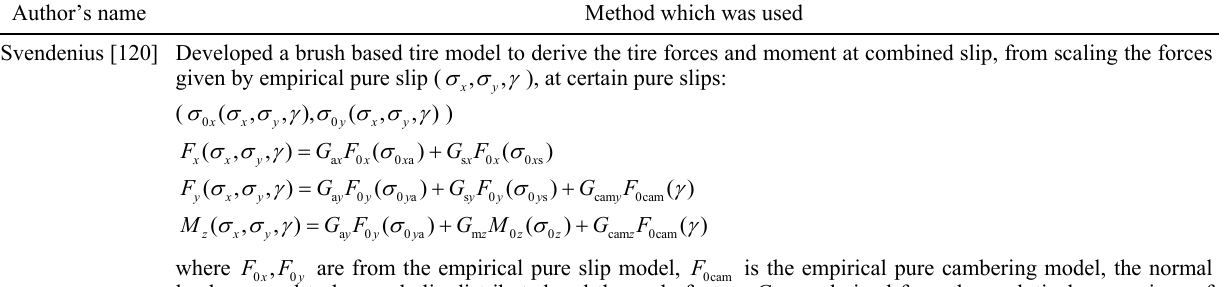
Table 6 Sample studies in which brush model have been used. Author’s name Method which was